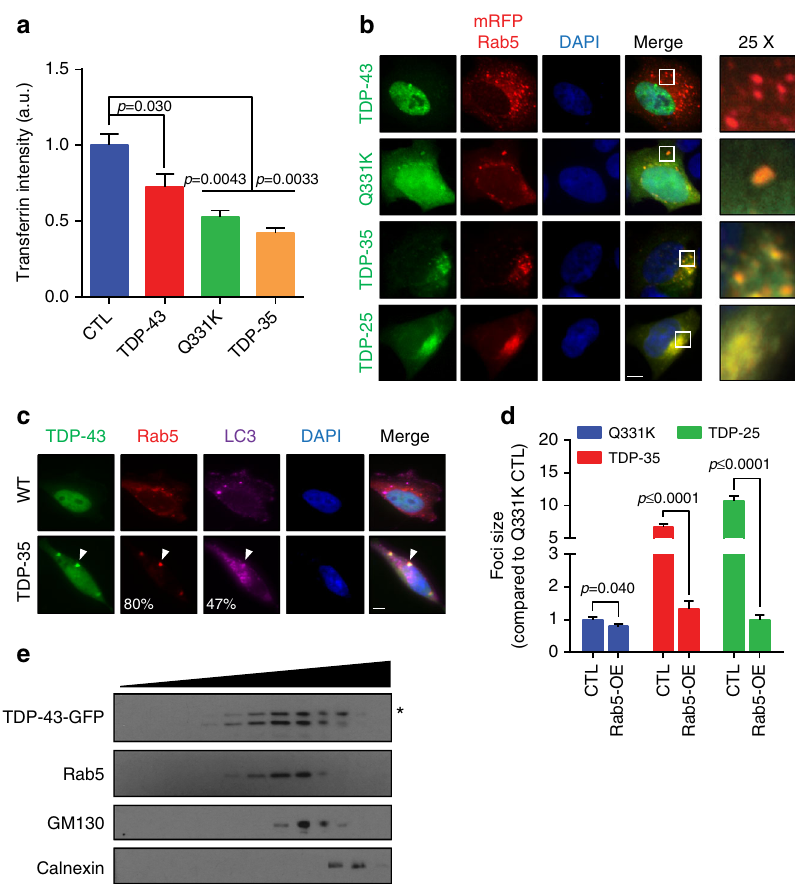
Fig. 5 TDP-43 foci co-localize with human cell endosomes. a HEK293A cells transfected with vector, TDP-43-, TDP-43 Q331K-, and TDP-35-GFP plasmids were stained with transferrin-633 and endocytosis rate was determined by cellular incorporation (Supplementary Fig. 6a). Signi fi cance was assessed by one-way ANOVA. Repeated data are shown as mean ± s.e.m. b HEK293A cells were transfected with Rab5-mRFP and either TDP-43-, TDP-43 Q331K-, TDP-35-, or TDP-25-GFP plasmids and examined via immuno fl uorescence. Scale bar = 5 µ m. c Immuno fl uorescence was performed in HEK293A cells transfected with TDP-43-GFP and TDP-35-GFP. The percentage of TDP-43 foci that co-localized with endogenous Rab5 or LC3 foci was calculated. Arrowhead indicates TDP-43 co-localization with Rab5 and LC3. Scale bar = 5 µ m. d Comparison of TDP-43 foci size +/ − Rab5 overexpression. Signi fi cance was assessed by two tailed Student ’ s t test. e Organelle fractionation was performed in TDP-43-transfected HEK293A cells. Detection of endogenous Rab5, GM130, and Calnexin indicate EE, Golgi, and ER components. The asterisk indicates full-length